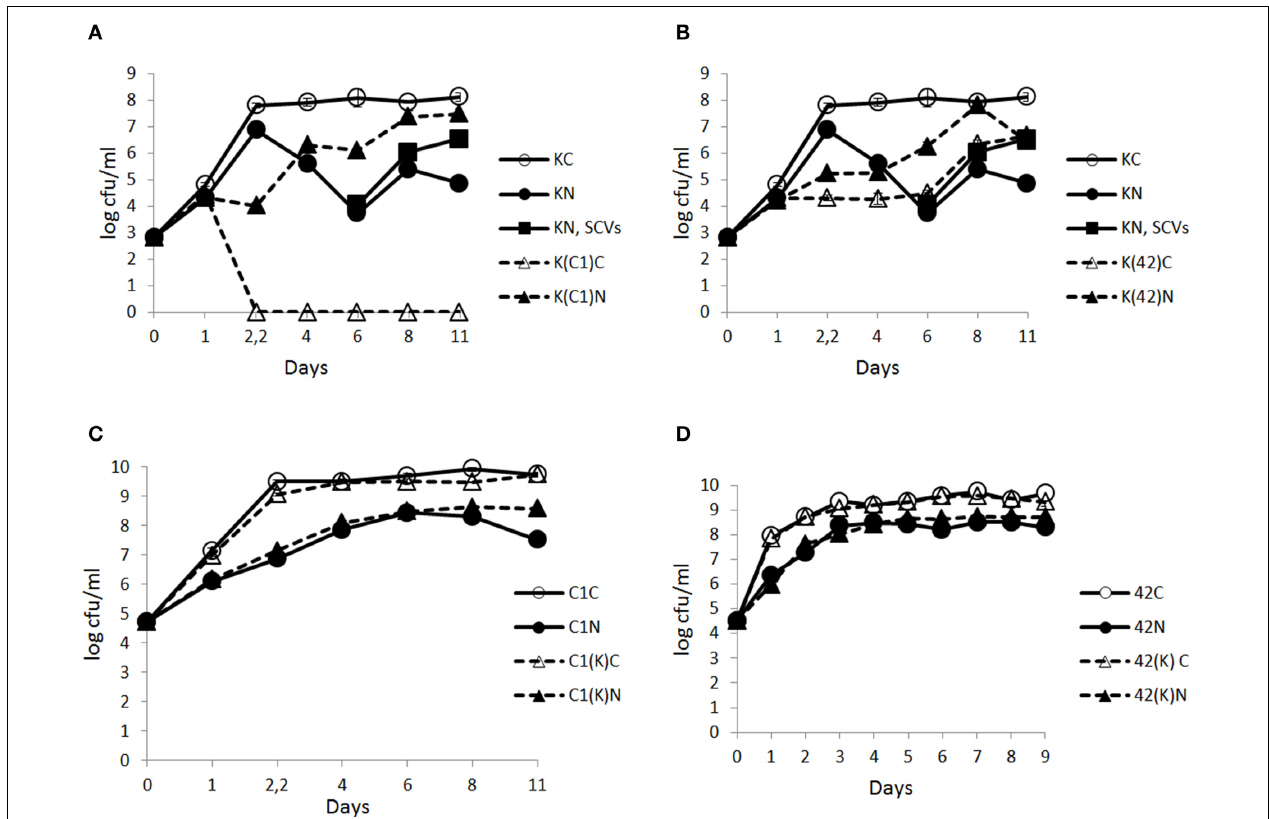
FIGURE 3 | Time-course analysis of the number (cfu/ml) of B. weihenstephanensis KBAB4 cells (K) established as mono-